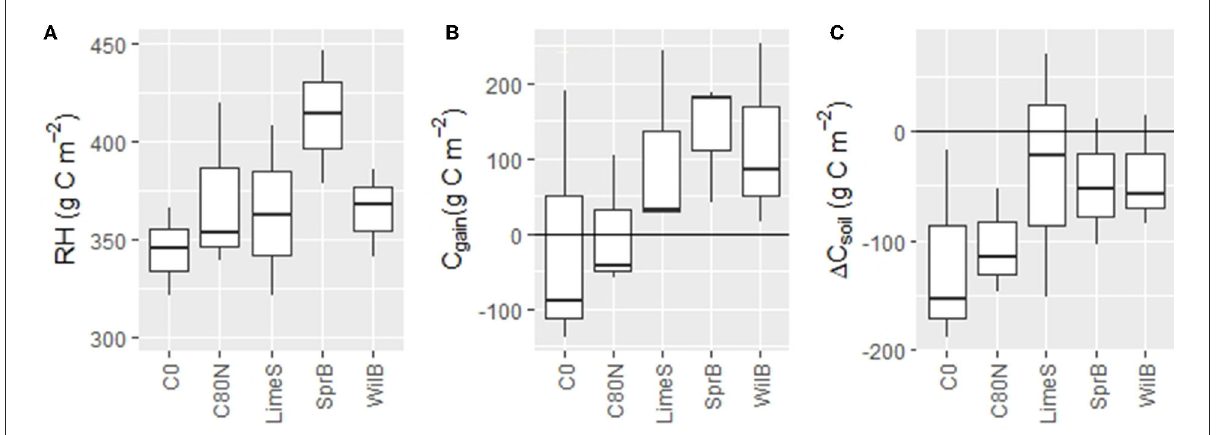
FIGURE9 Box-and-whisker plots of heterotrophic respiration [RH, (A) ], carbon gain between the ecosystem and the atmosphere as the difference between RH and biomass production (NPP) [C gain , (B) ], and the change in the soil carbon pool as the difference between the C gain and the removed yield [ 1 C soil , (C) ] during the campaign from 8 May to 20 November in 2018. Note the varying scale on the y-axes. C0, non-fertilized control; C80N, fertilized control; LimeS, lime-stabilized pulp sludge; SprB, spruce biochar; WilB, willow